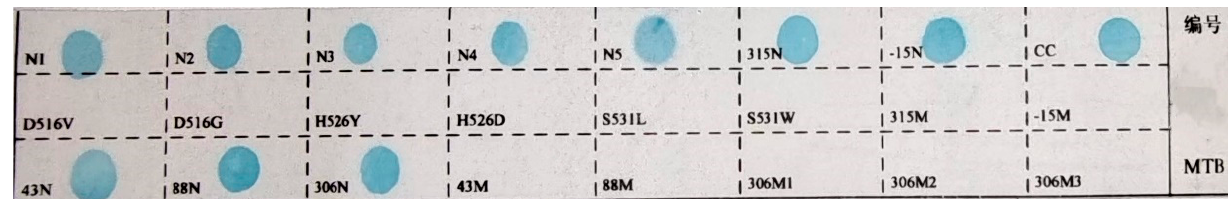
Figure 2. Sequence of detection site on membrane strip. rpoB gene [D516V, aspartate (D) → valine (V), a A → T mutation at nucleotide position 1547; D516G, aspartate (D) → glycine (G), a A → G mutation at nucleotide position 1547; H526Y, histidine (H) → tyrosine (Y), a C → T mutation at nucleotide position 1576; H526D, histidine (H) → aspartate (D), a C → G mutation at nucleotide position 1576; S531L, serine (S) → leucine (L), a C → T mutation at nucleotide position 1592; S531W, serine (S) → tryptophan (W), a C → G mutation at nucleotide position 1592]; katG gene (315 M, a G → C or G → A mutation at nucleotide position 944); inhA gene ( − 15 M, a C → T mutation at nucleotide position − 15); rpsL gene (43 M, a A → G mutation at nucleotide position 128; 88 M, a A → G mutation at nucleotide position 263); embB gene (306 M1, a G → H mutation at nucleotide position 918; 306 M2, a A → G mutation at nucleotide position 916; 306 M3, a A → C mutation at nucleotide position 916). The Chinese in the upper right corner means that you can write numbers in this area to number the membrane strips.